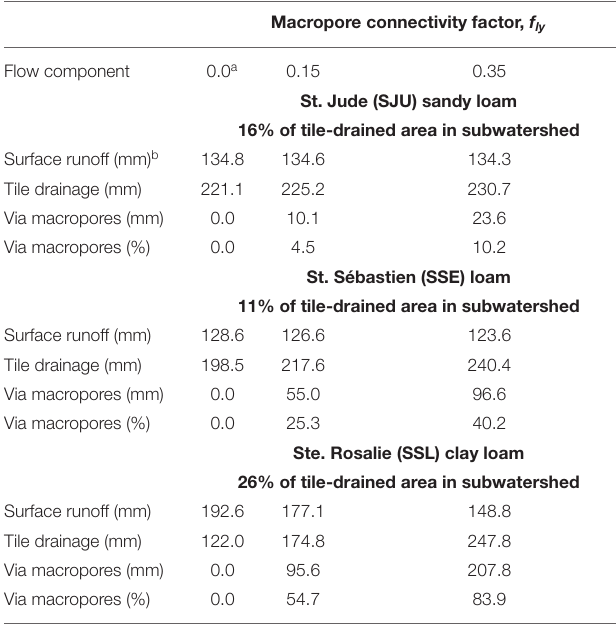
TABLE 6 | Mean annual surface runoff, tile drainage, and macropore flow predicted by SWAT-MAC under tile-drained areas of the three main soils in the Ewing subwatershed of the Pike River watershed, southern Quebec, Canada, for 6 years